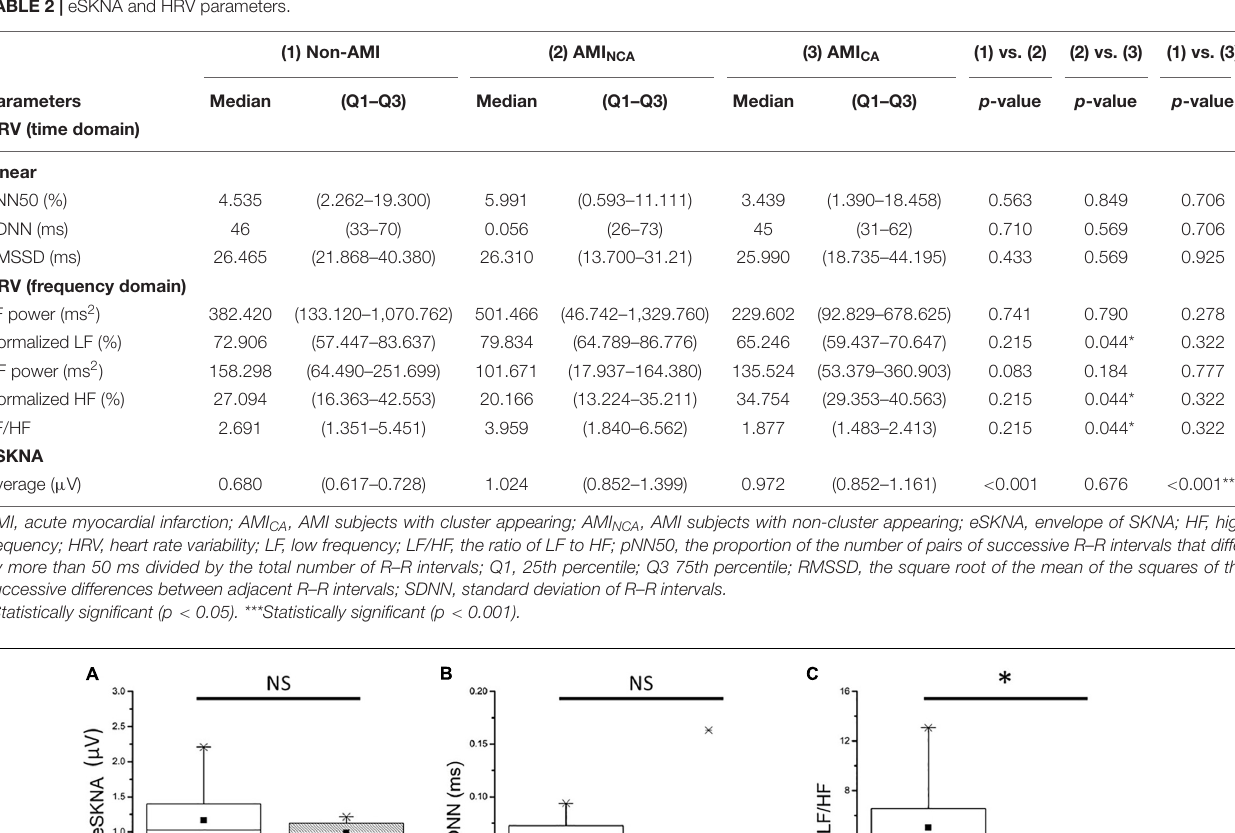
TABLE 2 | eSKNA and HRV